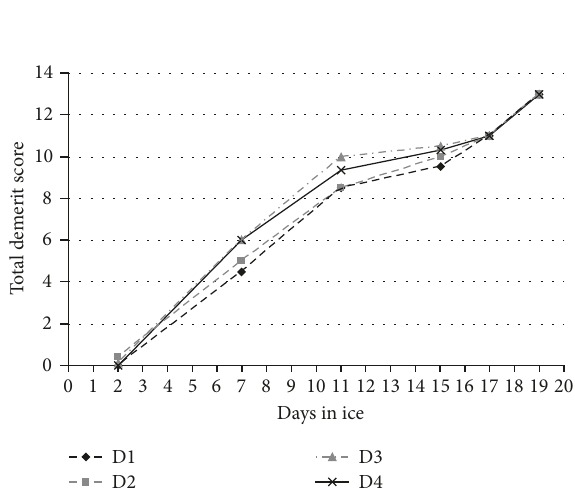
Figure 3: QIM freshness sensory scores for the four gilthead sea bream dietary groups (D1–D4) stored in